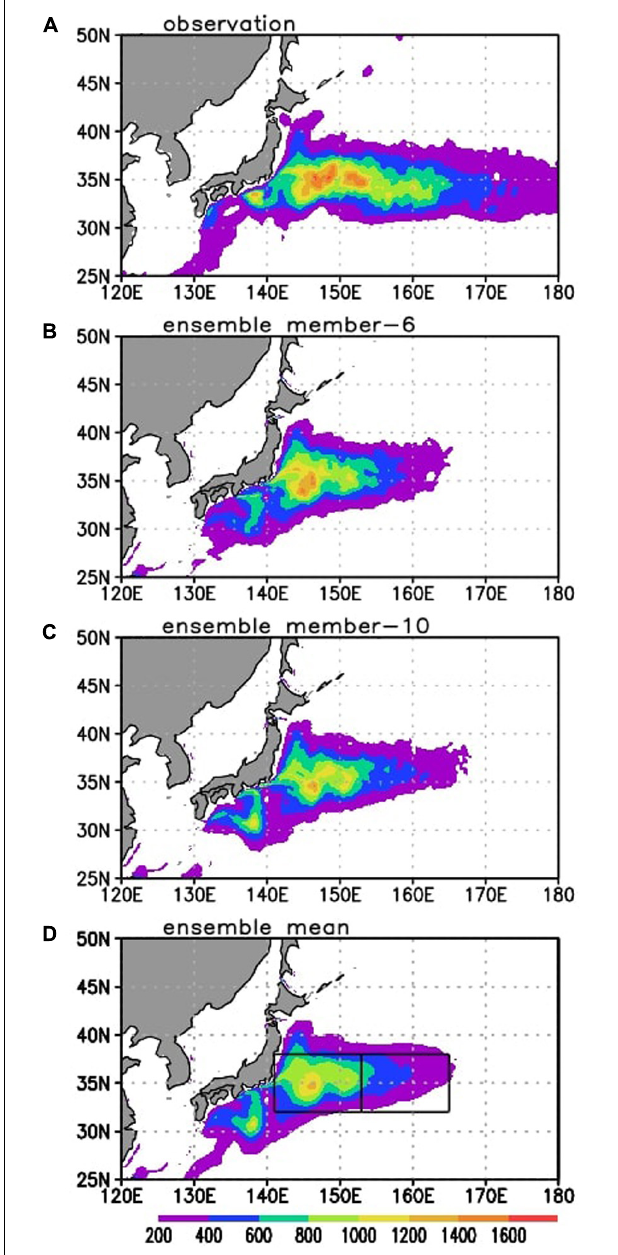
FIGURE 5 | (A) Long-term (July 1994–Jun 2016) averaged observed EKE. (B–D) Same as the top panel but for the simulated EKE (cm s − 1 ) 2 for the ensemble member with a (B) maximum and (C) minimum area-mean EKE in the high EKE region [32 ◦ –38 ◦ N, 141 ◦ –165 ◦ E], and for panel (D) the ensemble mean. The rectangles in the panel (D) indicate the upstream [32 ◦ –38 ◦ N, 141 ◦ –153 ◦ E] and downstream [32 ◦ –38 ◦ N, 153 ◦ –165 ◦ E] KE regions.